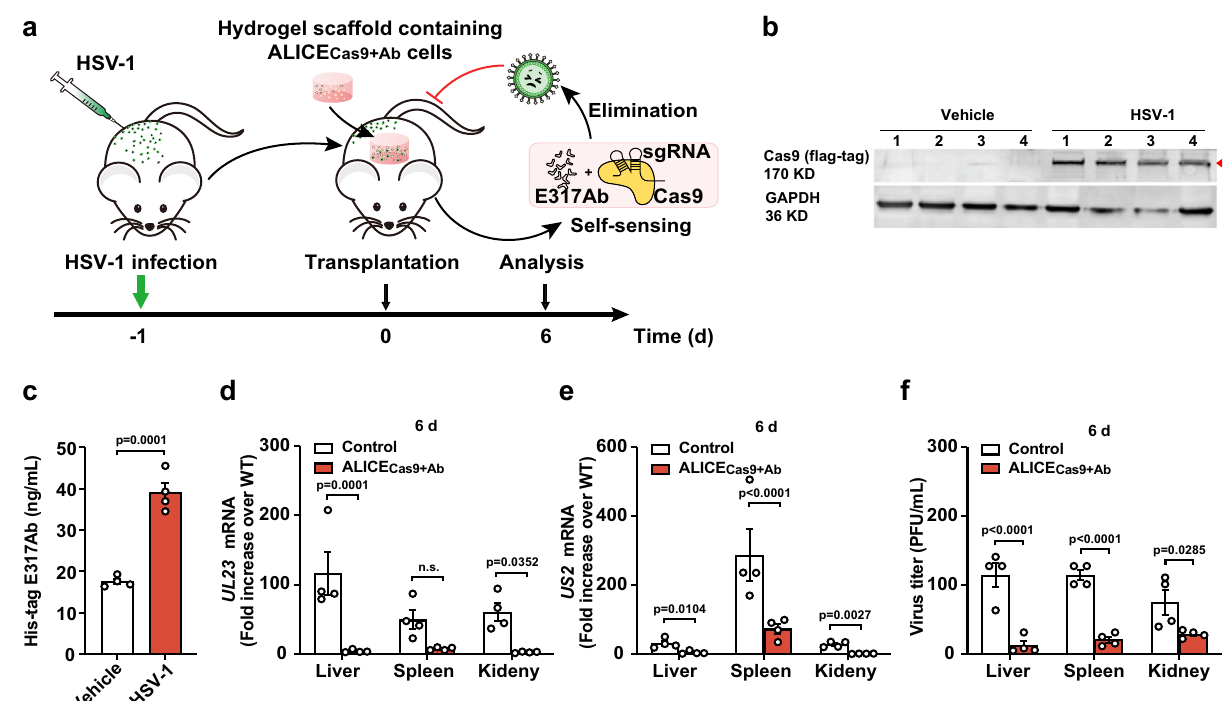
Fig. 6 | Sense-and-destroy against HSV-1 mediated by ALICE Cas9+Ab in a virus- infected mouse model. a Schematic illustration of ALICE Cas9+Ab for autonomous sense-and-destroy against HSV-1 in a virus-infected mouse model. Three sgRNAs (pYW102/pYW172/pYW188, respectively targeting US8 / UL29 / UL52 )-transgenic HEK ALICE-Cas9-E317Ab cells (ALICE Cas9+Ab ) or unmodi fi ed HEK-293T cells (Control) were encapsulated into hydrogel-based scaffolds. At 20 hpi of HSV-1 (2×10 7 PFU) by intraperitoneal injection, mice were implanted with the ALICE Cas9+Ab by intra- peritoneal surgery. The antiviral effects of ALICE Cas9+Ab in mice were evaluated by detecting viral titers in indicated mouse organs (liver, spleen, kidney) at 6 days post-transplantation. b WesternblotanalysisofHSV-1-inducibleCas9expressionin hydrogel-based scaffolds and c validation of HSV-1-inducible E317Ab expression. HSV-1-infected mice (2×10 7 PFU, HSV-1 group) or uninfected (0, Vehicle group) were all transplanted with hydrogel-based scaffolds containing pYW102/pYW172/ pYW188-transgenic HEK ALICE-Cas9-E317Ab cells. Total protein from hydrogel implants isolated from mice were extracted for Western blot analysis at 6 days post-